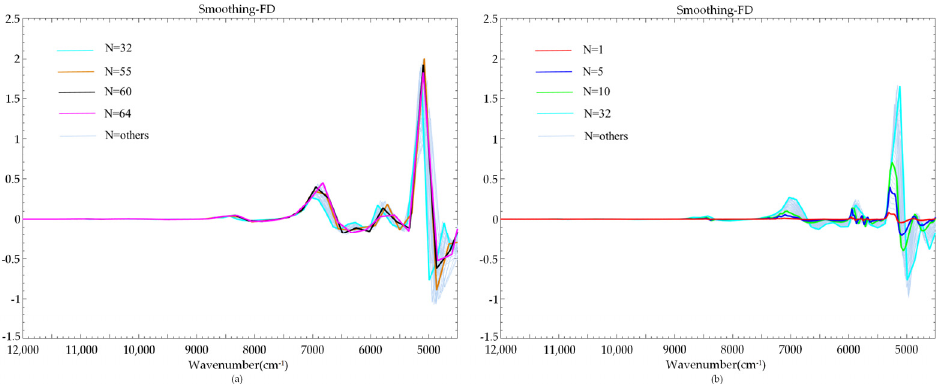
Figure 5. First derivative preprocessed spectra with different smoothing windows. ( a ) The smoothing window was between 1 and 32; ( b ) the smoothing window was between 32 and 64.